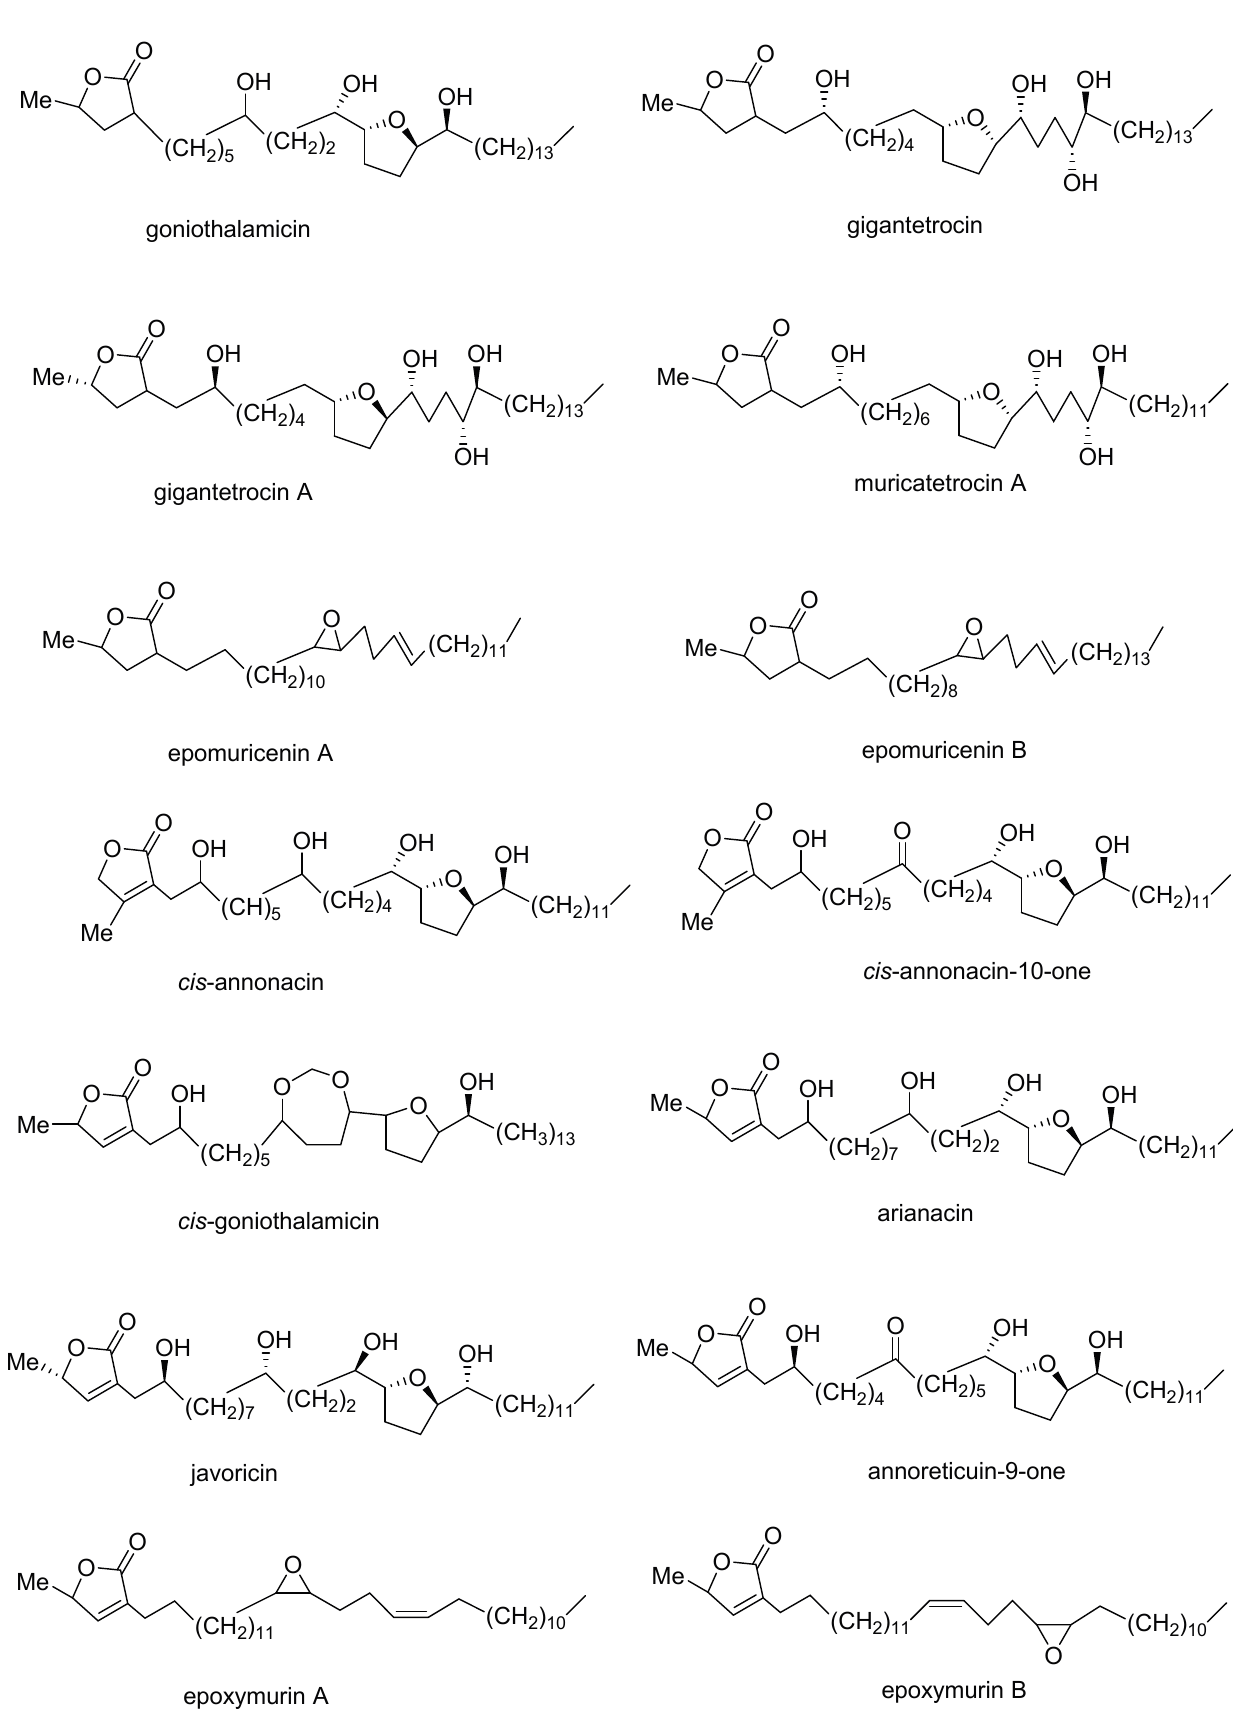
Figure 2. Chemical structures of the major compounds isolated from Annona muricata